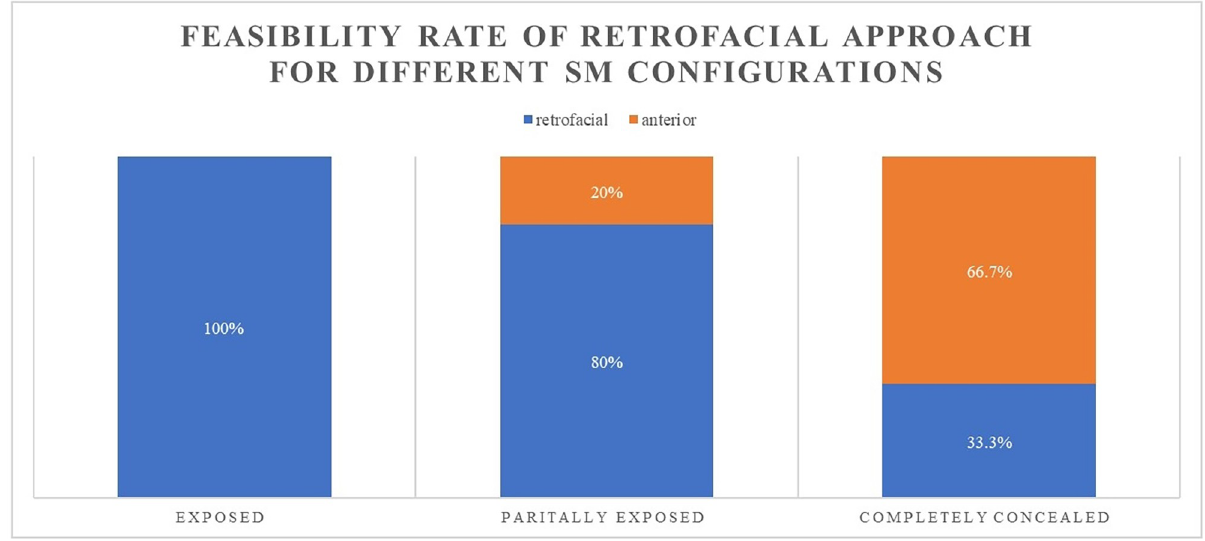
Fig 5. Bar chart summarizing the feasibility/success rate of the retrofacial approach in different configurations of the stapedius muscle respect to the facial nerve (according to [19]).